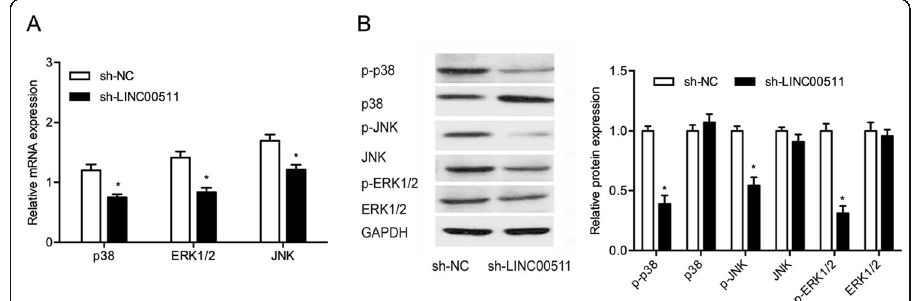
Fig. 3 LINC00511 promotes the activation of one of the MAPK signaling pathways. a MAPK-related gene mRNA expression following LINC00511 in BGC823 cells. b The effects of LINC00511 knockdown on MAPK- related gene protein expression in BGC823 cells. * p <